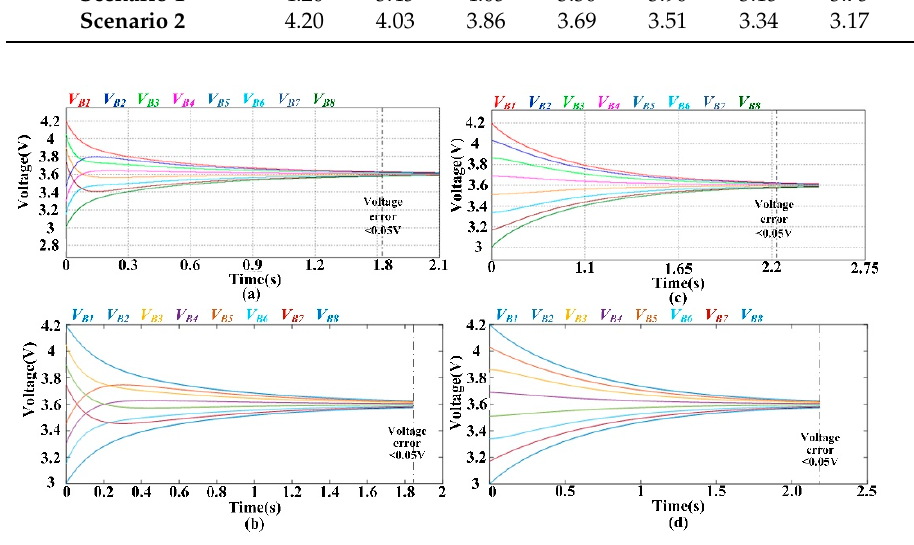
Figure 17. Voltage curves of double-tiered SC-based BE during equalization: ( a ) scenario 1 using PSIM; ( b ) scenario 1 using MATLAB; ( c ) scenario 2 using PSIM; ( d ) scenario 2 using MATLAB.